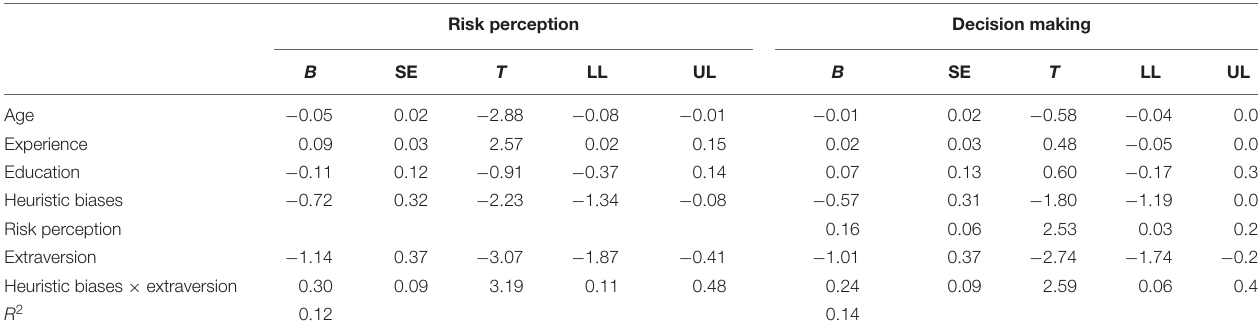
moderates both of these relationships. Based on survey data collected from 247 investors registered in various brokerage houses in Pakistan, the results of this study supported the hypothesized relationships.